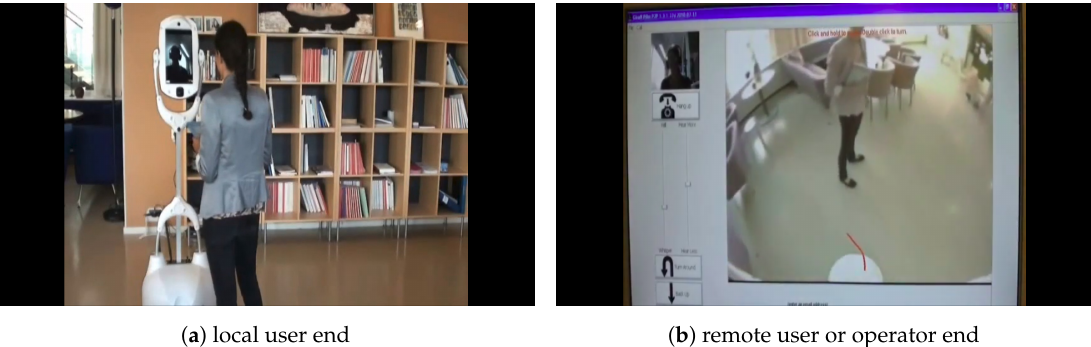
Figure 1. The Giraff robot’s [12] two-end setup. ( a ) A local user is talking to the teleoperator on the screen. ( b ) Operator end with the graphical user interface (GUI) present on the